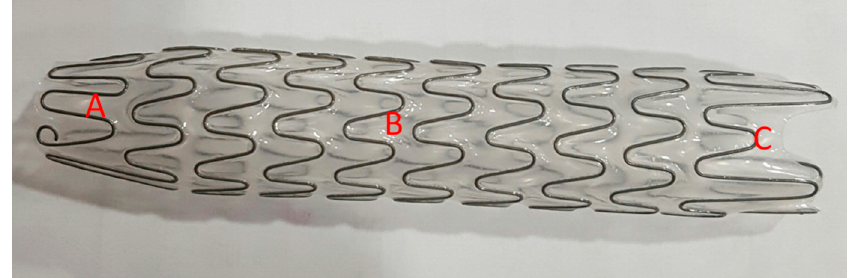
Figure 1. An Allium bulbar urethral stent (BUS). ( A ) Soft sphincteric segment; ( B ) high radial force body; ( C ) soft distal segment.